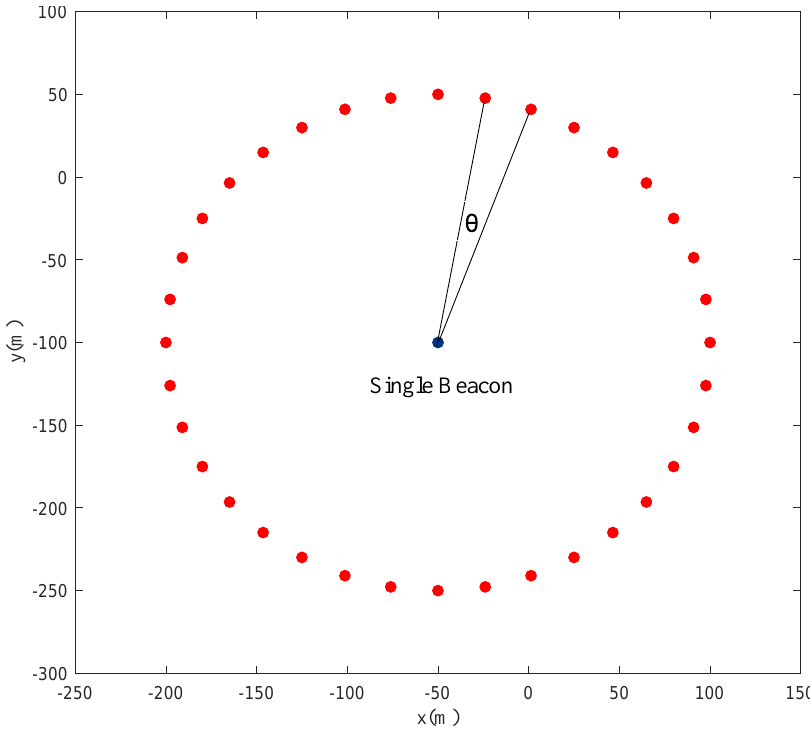
Figure 3. Illustration of PAA in MHIPD